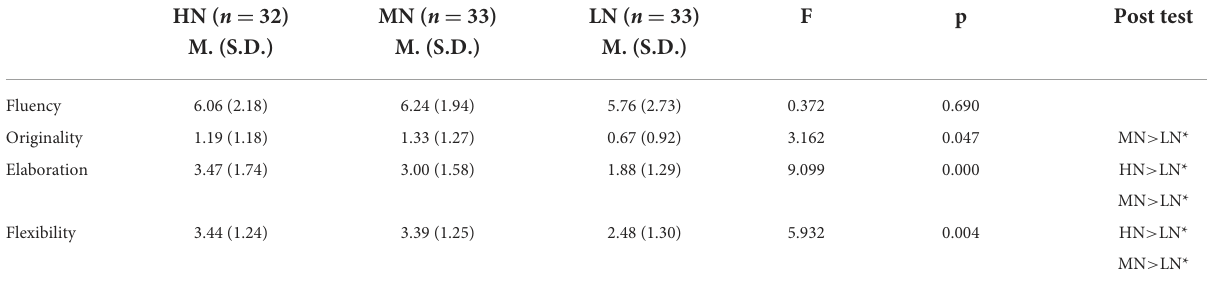
TABLE 3 One-way ANOVA analysis on the original score of ATTA’s Figural Activity 2 in landscape environments with different perceived